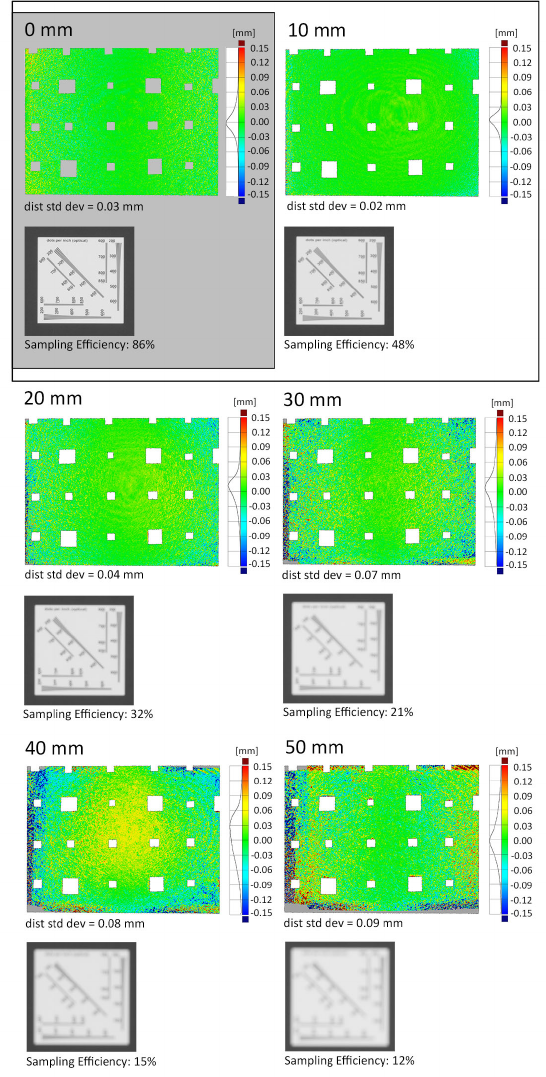
Figure 6. Surface discrepancy maps comparing 3D reconstructions (f/5.6 image sets) with averaged reference mesh at different camera-object distances. Image details of the DICE target central feature visualize decreasing sampling efficiency with changing camera-object distance. The grey box indicates result within the FADGI star rating and the white box indicates positions within the calculated DOF.